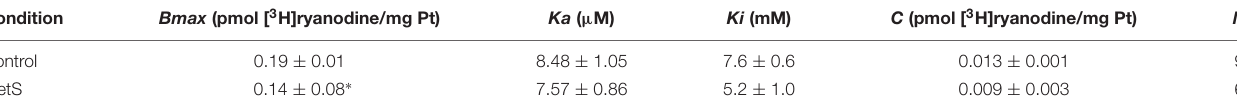
TABLE 3 | Ca 2 + -dependence of [ 3 H]-ryanodine binding in microsomes of MetS and controls hearts. Condition